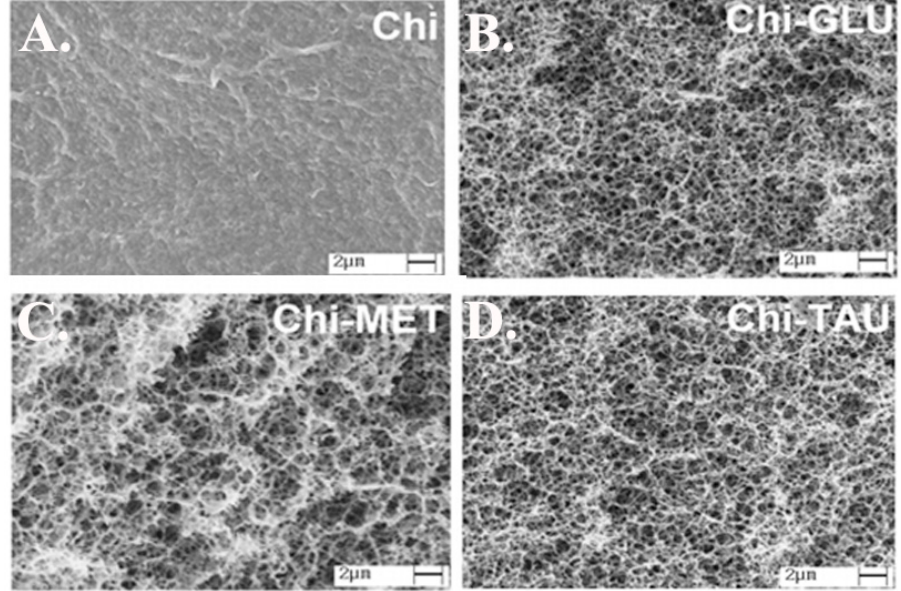
Figure 3. Improvement of the structure of chitosan after functionalization by adding amino acids: ( A ) chitosan, ( B ) chitosan- glutamic acid (GLU), ( C ) chitosan-methionine (MET), and ( D ) chitosan- taurine (TAU). Reproduced from [128].